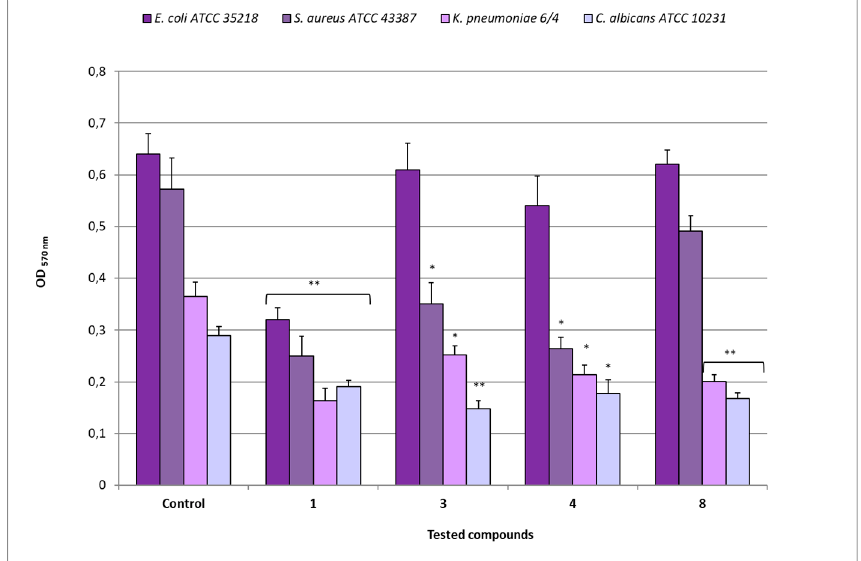
Figure 7. Disaggregating efficacy of compounds 1 , 3 , 4 , and 8 at their relative MIC values, against biofilms of E. coli ATCC 35218, S. aureus ATCC 43387, K. pneumoniae 6/4 and C. albicans ATCC 10231, as assessed by spectrophotometer reader (OD 570nm ) after 30 min of contact. Data represent the mean ± SD obtained in three independent experiments performed in duplicate. Asterisks represent values statistically significant (* p < 0.05; ** p < 0.01) as compared to the related controls.